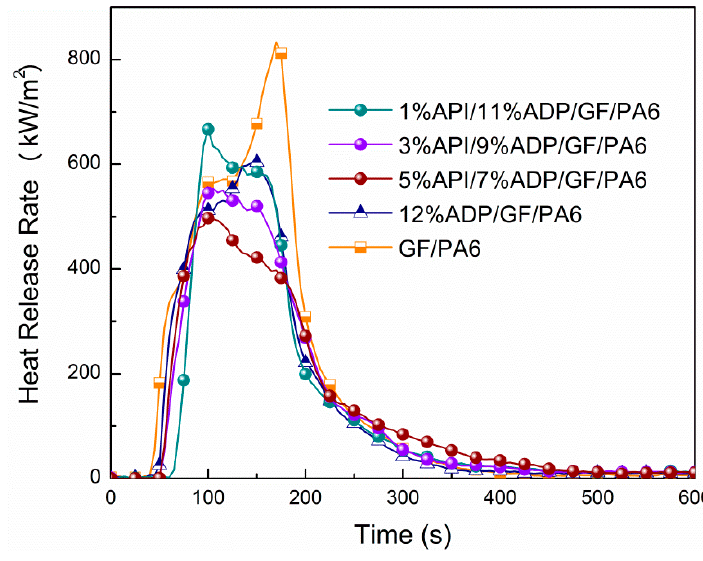
Figure 2. HRR curves of PA6 composites in the cone calorimeter test.